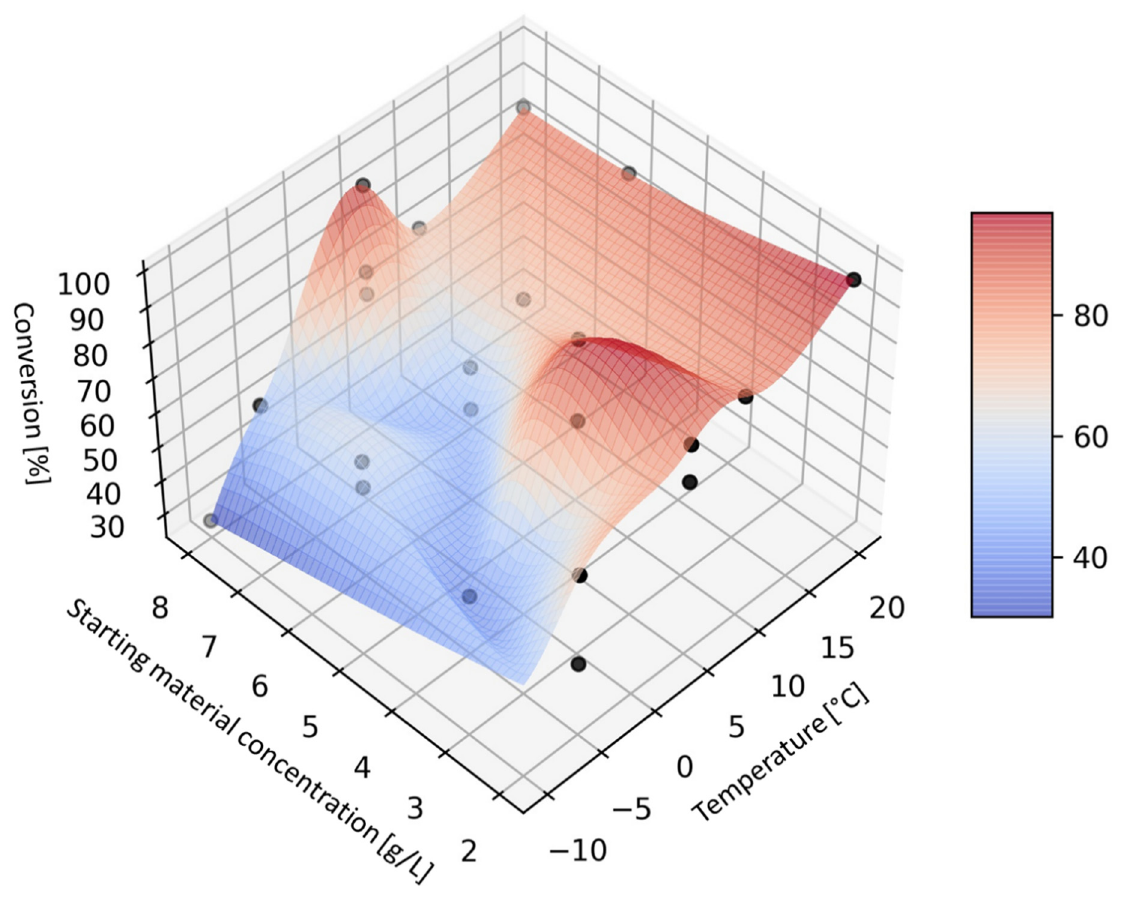
Figure 2. Graph of conversion as a function of temperature and concentration of silybin diastereomeric mixture.